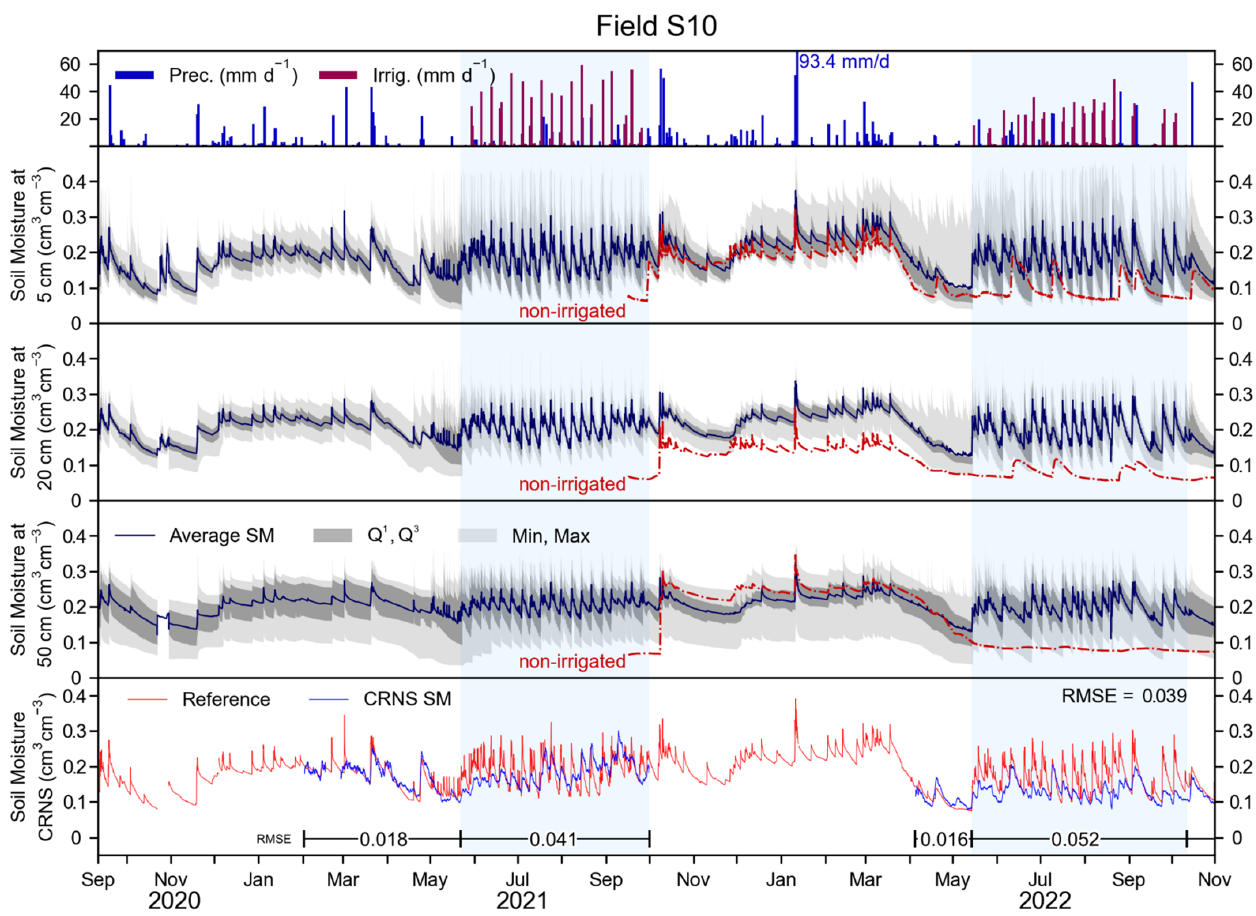
Figure 4. Data recorded in field S10. In the upper panel: precipitation, and irrigation in mm d − 1 . In the three central panels: SM recorded from the SoilNet network at 5, 20, and 50 cm depths. Dark grey areas indicate the first and third quartile, whereas light grey area indicates maximum and minimum values for the SM of these panels. In the bottom panel: reference SM from weighting the SoilNet network and CRNS-derived SM. Regressions of these measurements are provided in Appendix C.